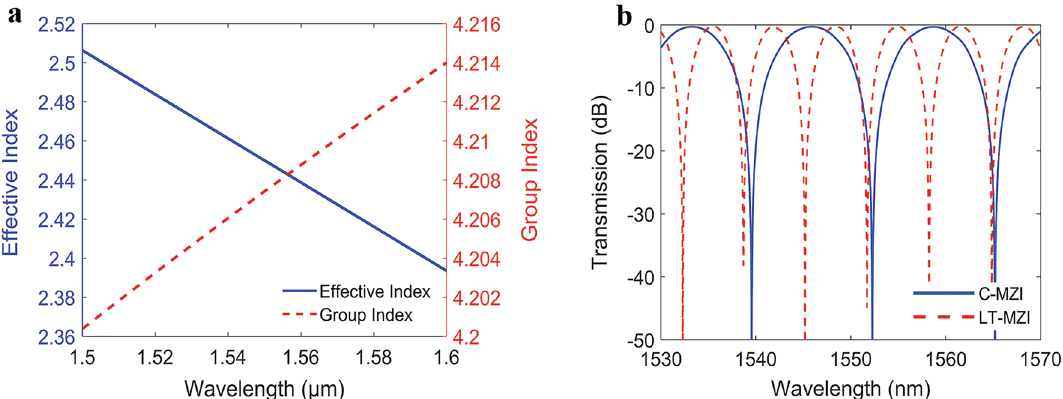
Figure 2. ( a ) Effective index and group index versus wavelength for the fundamental TE like mode of the (500nmx220nm) strip waveguide obtained from mode solver and ( b ) output transmission spectra versus wavelength of both LT-aMZI and C-aMZIY for path length differences ΔL = 44.7